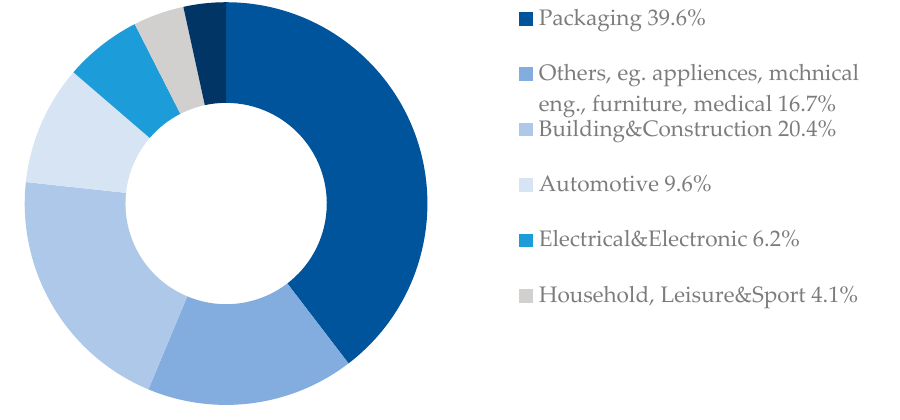
Figure 5. Plastics demand by segment 2019 in EU [19].